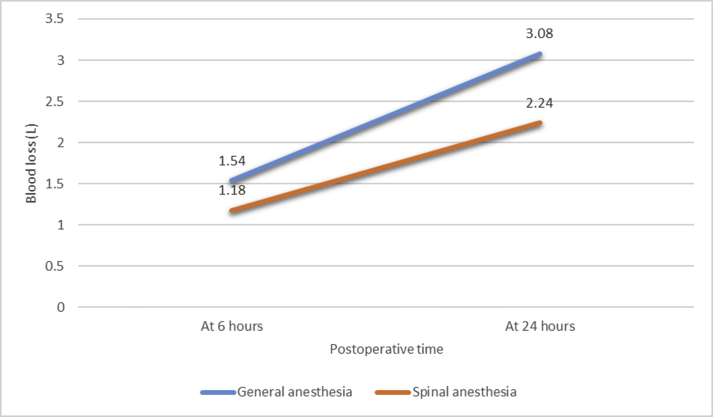
legend: Chart indicating the relation between Hb loss and type of anesthesia.